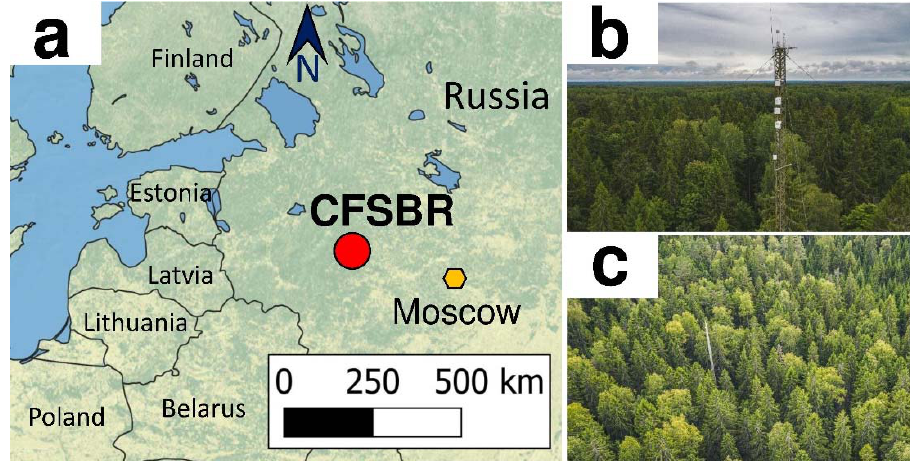
Figure 1. ( a ) Location of Central-Forest state biosphere reserve (CFSBR) on the map; photos of the flux stations ( b ) in the nemorose spruce forest (Ru-Fy2) and ( c ) in the paludified spruce forest (Ru-Fyo; see Section 4.3). Photographer: Dmitry Ivanov (see Acknowledgements).